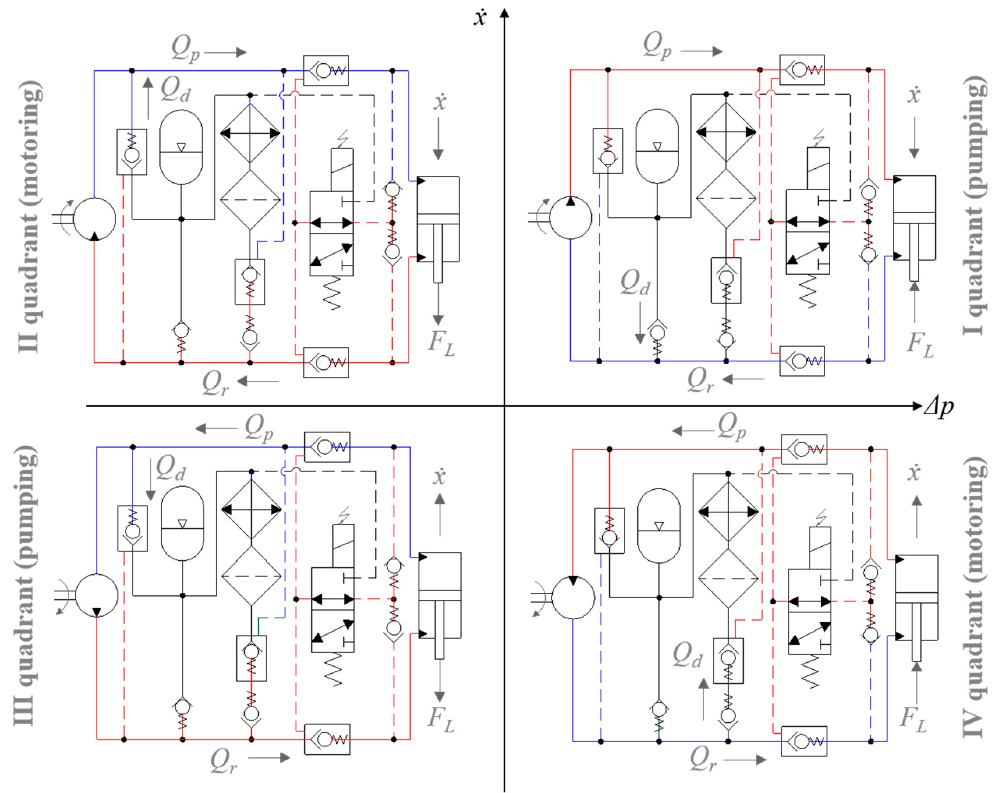
Figure 3. Simplified illustration of the system functioning in four quadrants ( Δ p = p 1 − p 2 ).